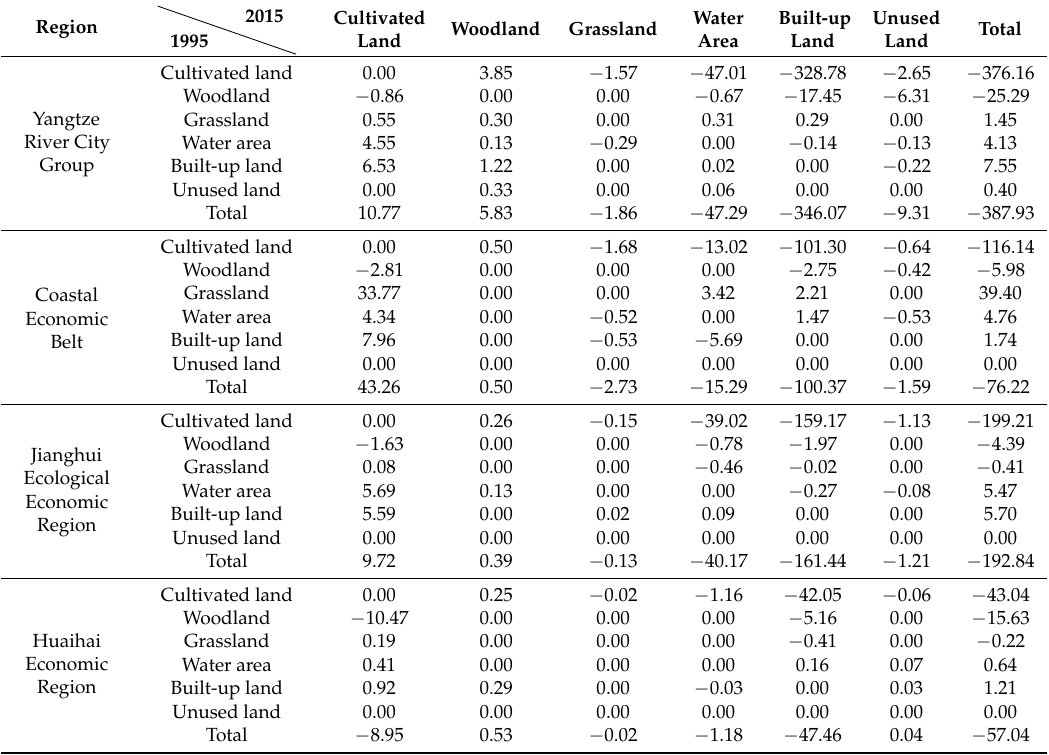
Table 7. The carbon storage transfer matrix for the Jiangsu Province between 1995 and 2015 ( × 10 4 t).